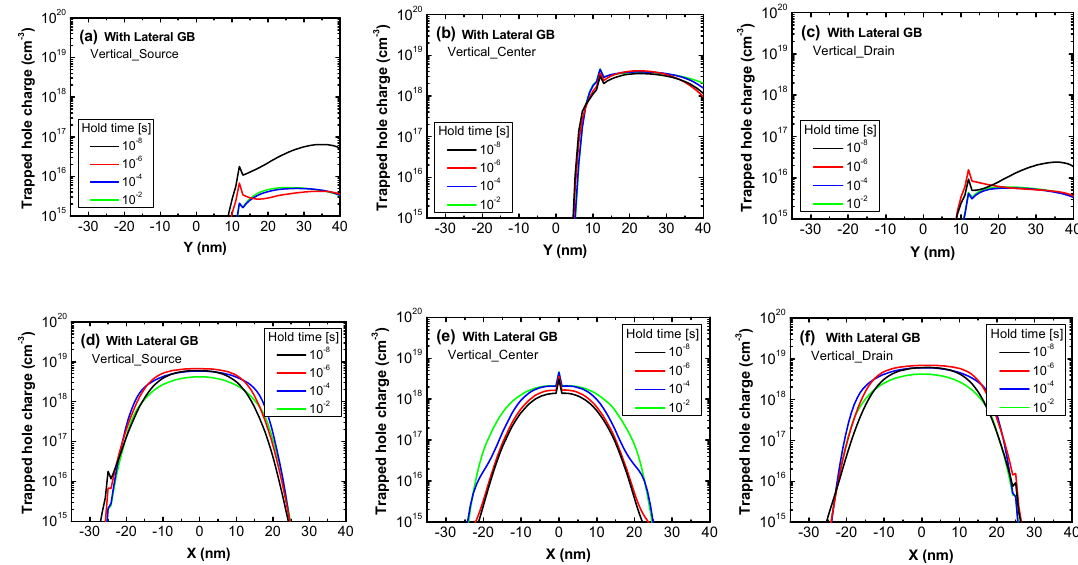
Figure 9. The trapped hole charge of poly-Si 1T-DRAM devices with lateral GB in the Read “1” operation as a function of the position within ( a – c ) a vertical GB and ( d – f ) a lateral GB. The lines in each figure represent varied hold times to show their effect on the trapped hole charge. The devices are ( a ) and ( d ) Vertical_Source; ( b ) and ( e ) Vertical_Center; and ( c ) and ( f ) Vertical_Drain.